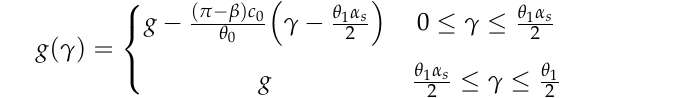
Figure 9. Distribution of